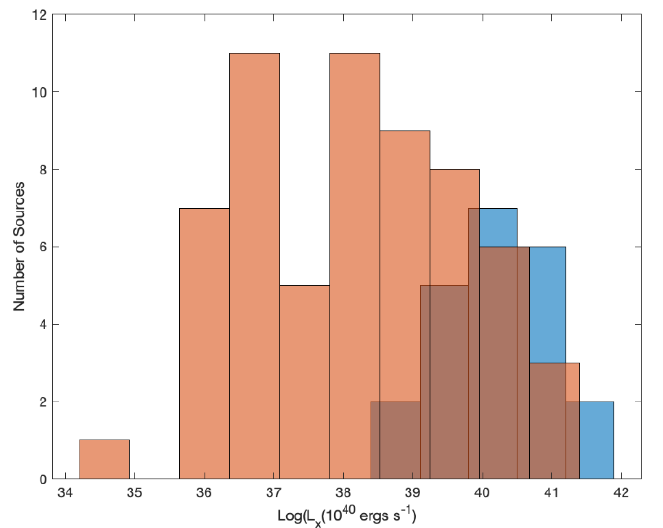
Figure 11. Comparison of nuclear X-ray sources in a SINGS sample of nearby galaxies (orange) to IGL core sources (blue). The samples are different with > 99.9% probability.